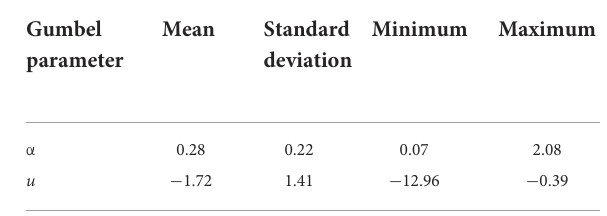
TABLE 4 Descriptive statistics for α and u , after implementing a 31 × 31 moving average and a 3 × 3 moving average, based on extrapolated D values of the 5,000-, 10,000-, 15,000-, and 20,000-year return periods, for locations flooded by only one (i.e., 500-year) or no return periods, after removal of spurious cells, for the Metairie, Louisiana, study